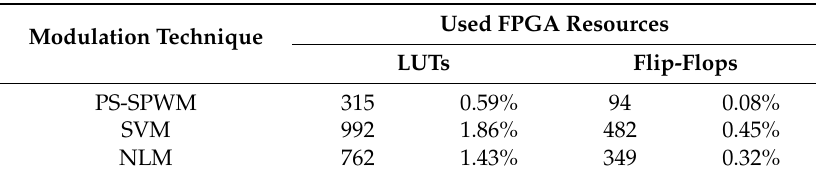
Table 3. FPGA Resources.